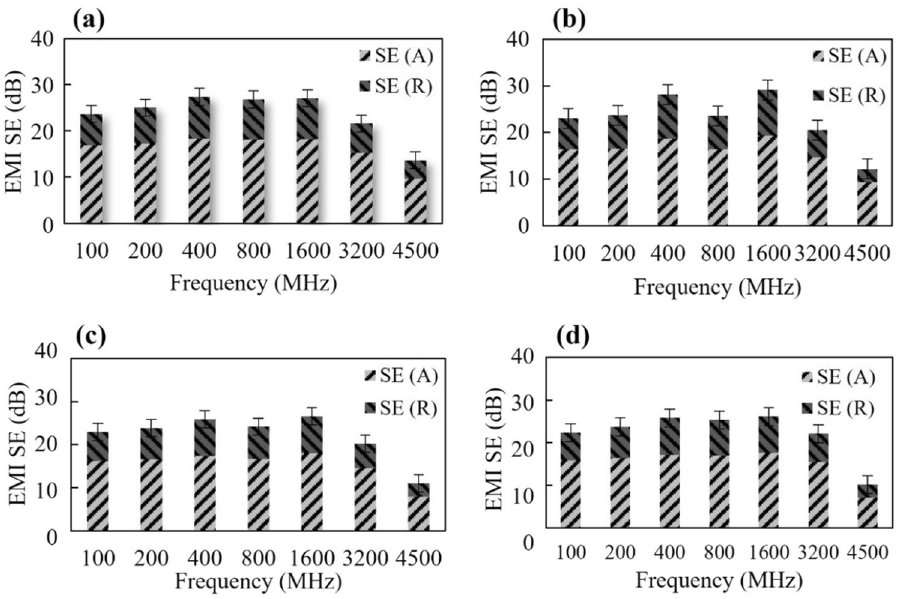
Figure 14. Distribution of total EMI-SE ( a ) GP-1, ( b ) GP-2, ( c ) GP-3 and ( d )